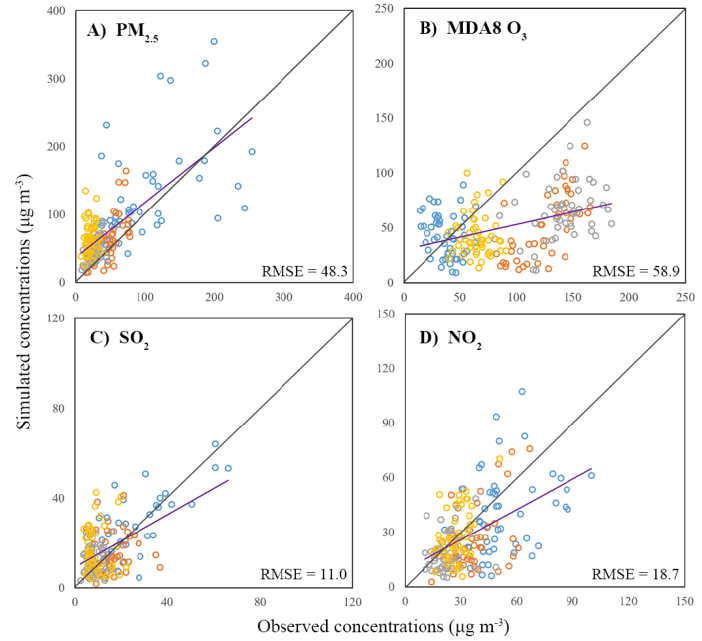
Figure 3. Comparison between observed concentrations and simulated concentrations of ( A ) PM 2.5 , ( B ) MDA8 O 3 , ( C ) SO 2 and ( D ) NO 2 air pollutants in 50 cities located in the study domain. The blue circles, orange circles, gray circles, and yellow circles indicate air pollutant concentrations in January, April, July, and October, respectively. The middle solid line represents the 1:1 line and the purple solid lines represent the trend of datasets. RMSE represents root mean squared error (unit: µ g m − 3 ).